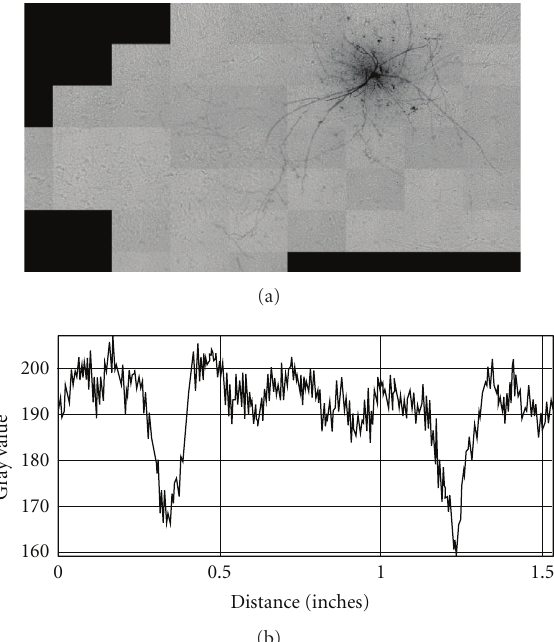
Figure 9: Neurological confocal microscopy image of Hippocampal CA3 Interneuron with polynomial noisy background: (Image data courtesy from Professor German